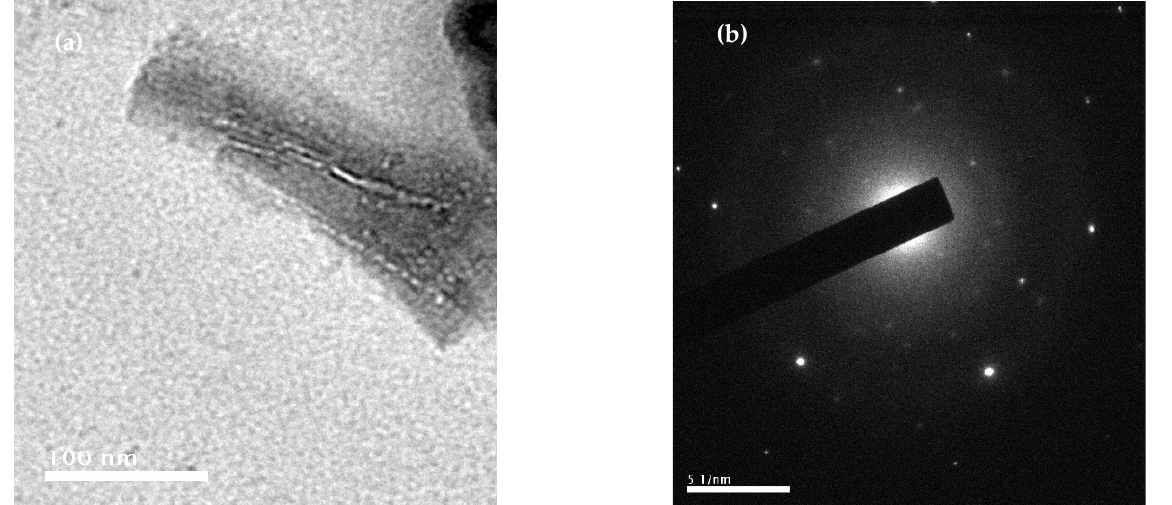
Figure 1. ( a ) TEM image and ( b ) electron diffraction pattern of PN.